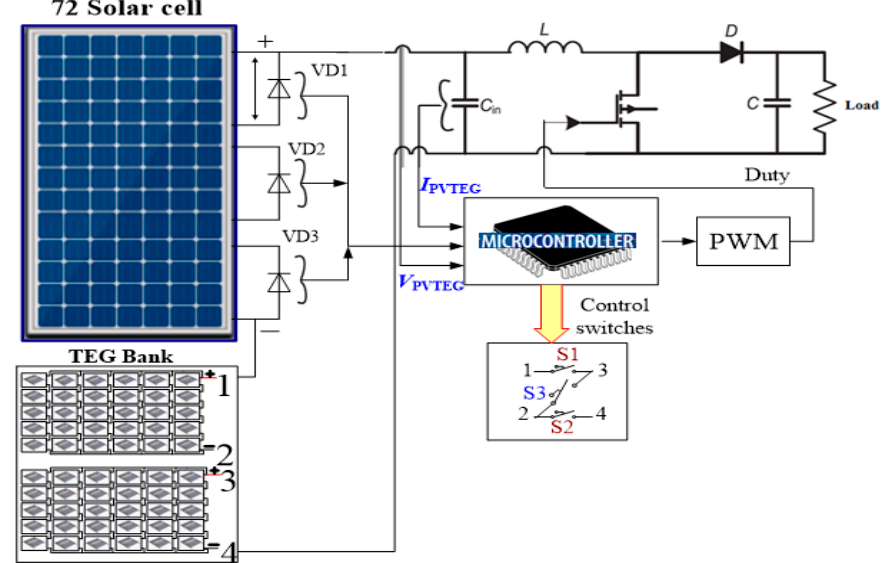
Figure 3. Schematic diagram of HPVTEG integrated with MPPT. Mathematics 2019 , 7 , 875